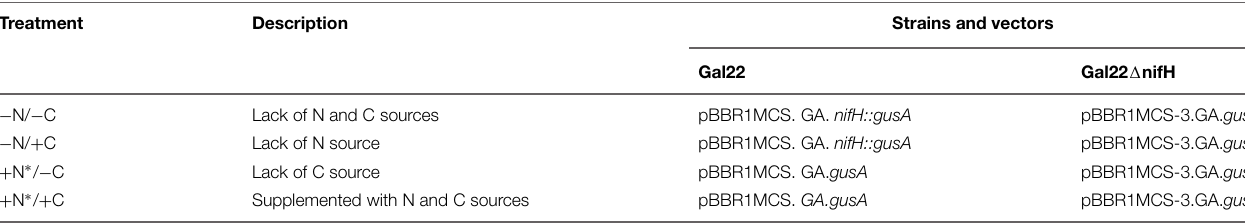
TABLE 3 | Description of the four different treatments used to assay colonization of M. mangrovicola Gal22 on R. mangle roots.